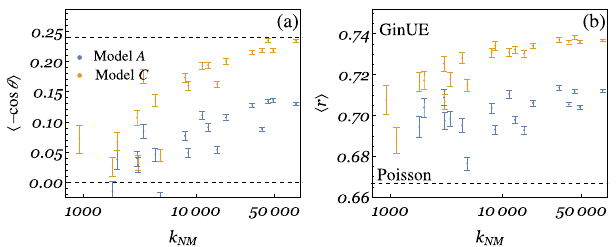
FIG. 8. Finite-size effects on the complex spacing ratios of spin-chain Liouvillians of model A (blue) and model C (orange). We consider different chain lengths N and spin sectors M , the 2 N sector dimension being k Þ . (a) Average value of cos θ ; NM ¼ ð M (b) average value of r . The upper (lower) dashed line corresponds to the GinUE (Poisson)